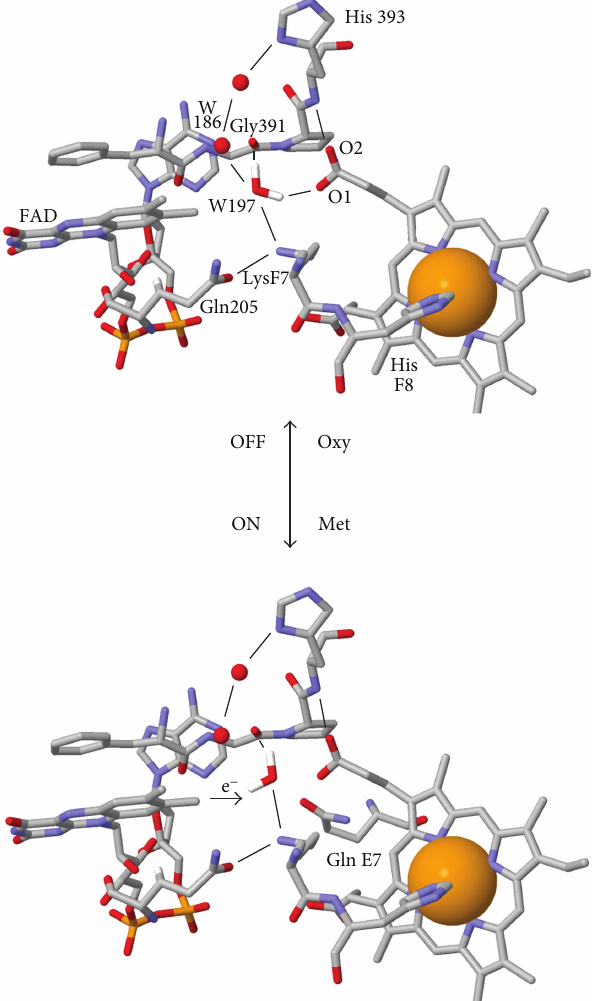
F3:Proposedrotationofabridgingwatermoleculeasamech- anism for electron transfer control. E. coli �avoHb electron transfer bridge structure showing proposed changes in the orientation of the bridging water molecule (W197) leading to water polarity changes and ON and OFF states controlling electron